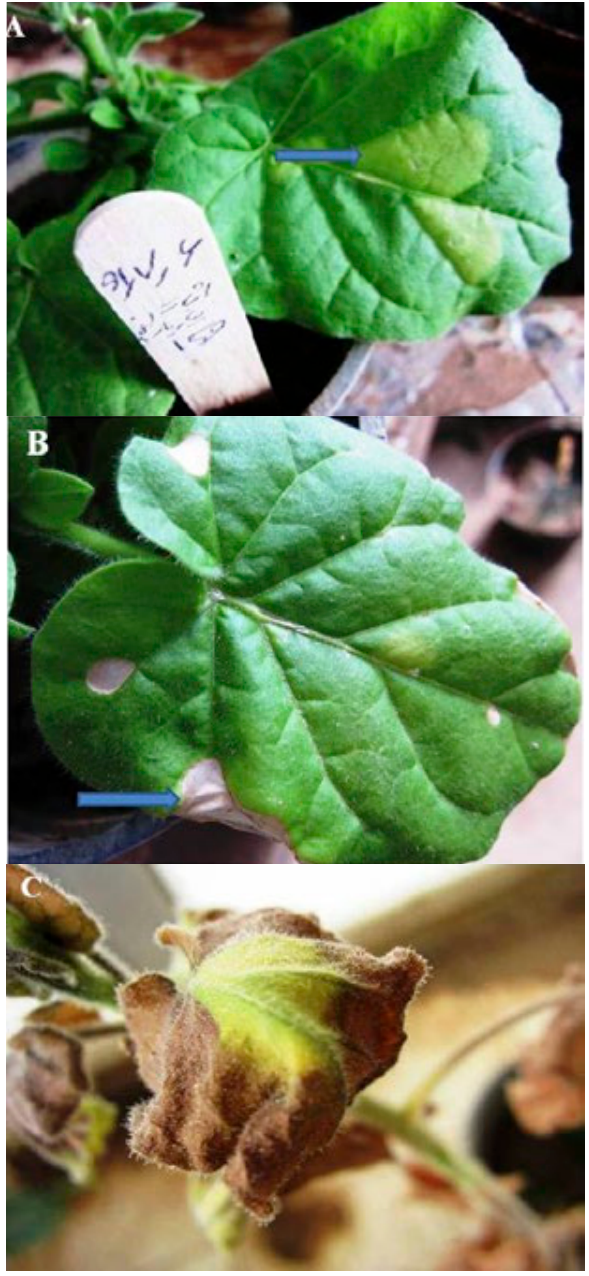
Figure 3. Progressive development of tobacco leaf symp- toms after inoculation with Xylella fastidiosa . (A) Chloro- sis of vein areas (inoculation site) 8 d after inoculation. (B) Chlorotic area at leaf margin, 3 weeks after inoculation. (C) Necrosis of a leaf 3 months after inoculation.